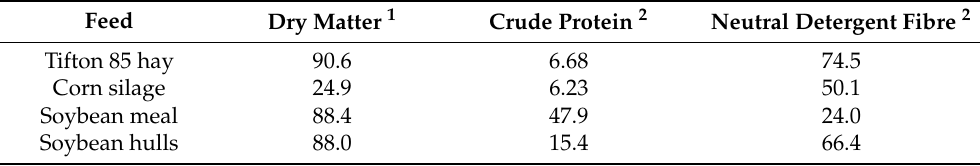
Table 1. Chemical composition of feeds used for evaluating in vitro dry matter digestibility. Feed Dry Matter 1 Crude Protein 2 Corn silage Soybean meal 88.4 Soybean hulls